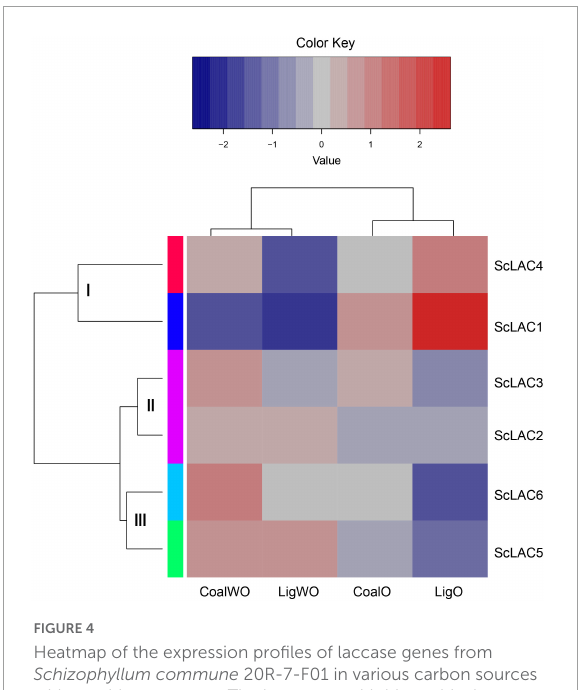
FIGURE4 Heatmap of the expression profiles of laccase genes from Schizophyllum commune 20R-7-F01 in various carbon sources with or without oxygen. The heatmaps with hierarchical clustering were visualized using the software heatmap2 and the values were log2-transformed with normalization. The blue and red elements indicate low and high relative expression levels,